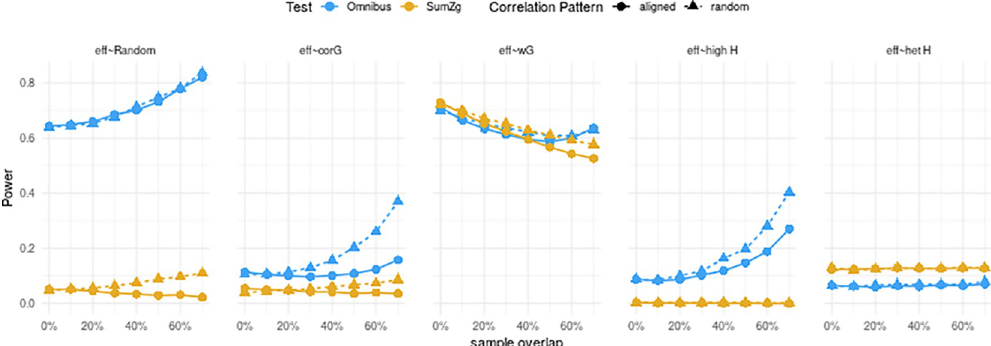
Fig 1. Statistical Power of the omnibus and sumZ sumZ g tests with respect to sample overlap. Color of the line represents the test. Each panel correspond to a simulation scenario. Point shape indicates if the residual covariance was generated to be partially aligned with the genetic covariance or to be unconstrained (random). A 10 trait Z-score vector was generated as the sum of a genetic effect and a residual effect: Z = Z g + Z res . Z res was sampled from a normal multivariate distribution with covariance matrix terms equal to s ffiffiffiffiffiffiffiffiffi r n = n 1 n 2 s